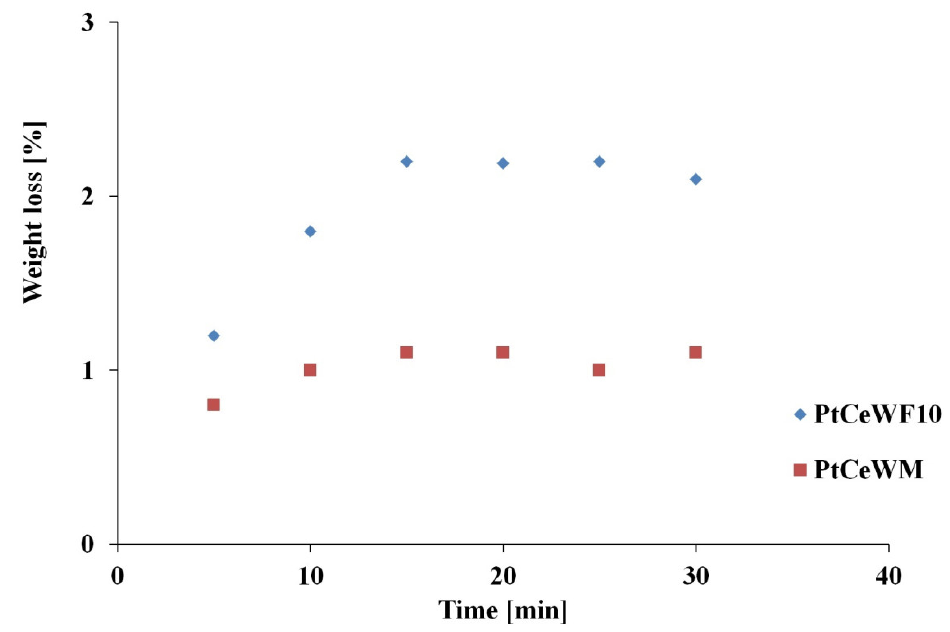
Figure 1. Washcoat weight losses during the ultrasonic adherence tests. PtCeWF10— Pt/ceria/washcoat/foam 10_10/12; PtCeWM—Pt/ceria/washcoat/monolith.